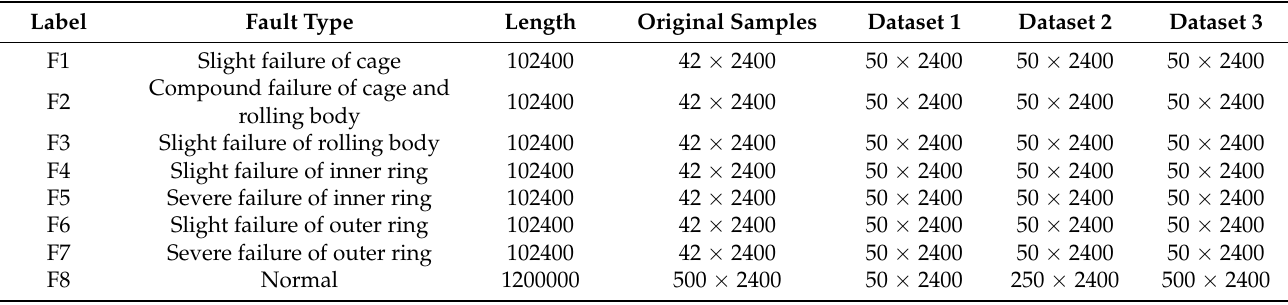
Figure 6. The locomotive bearing test rig. It is from a locomotive depot of the China Railway Administration. It mainly contains a hydraulic system, a spindle box, hydraulic loading, and three accelerometers at different locations. Table 1. A detailed description of the bearing data